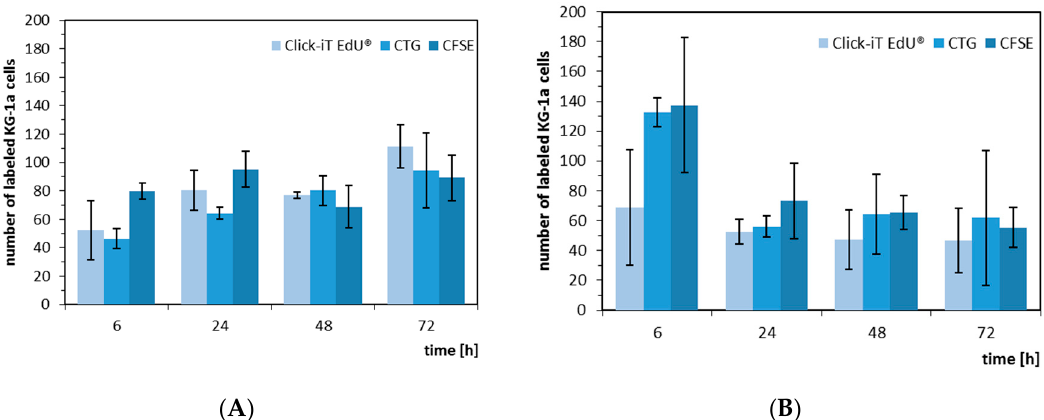
Figure 5. Absolute number of proliferating KG-1a cells in co-culture with Hep G2 ( A ) and hMSC ( B ). The KG-1a cells were labelled with either EdU (light blue), CellTracker TM Green (medium blue), or CFSE (dark blue) and, after labelling, cultivated for 6, 24, 48, and 72 h.